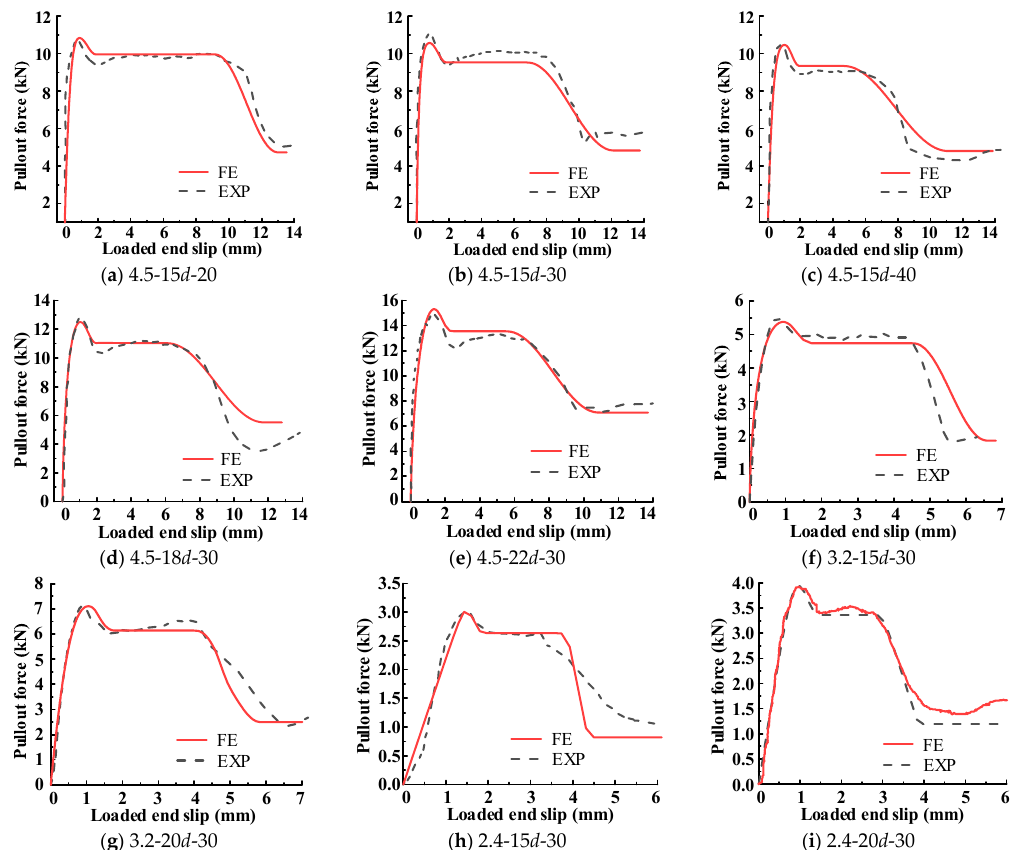
Figure 12. Comparison of force slip curves between simulation and test.